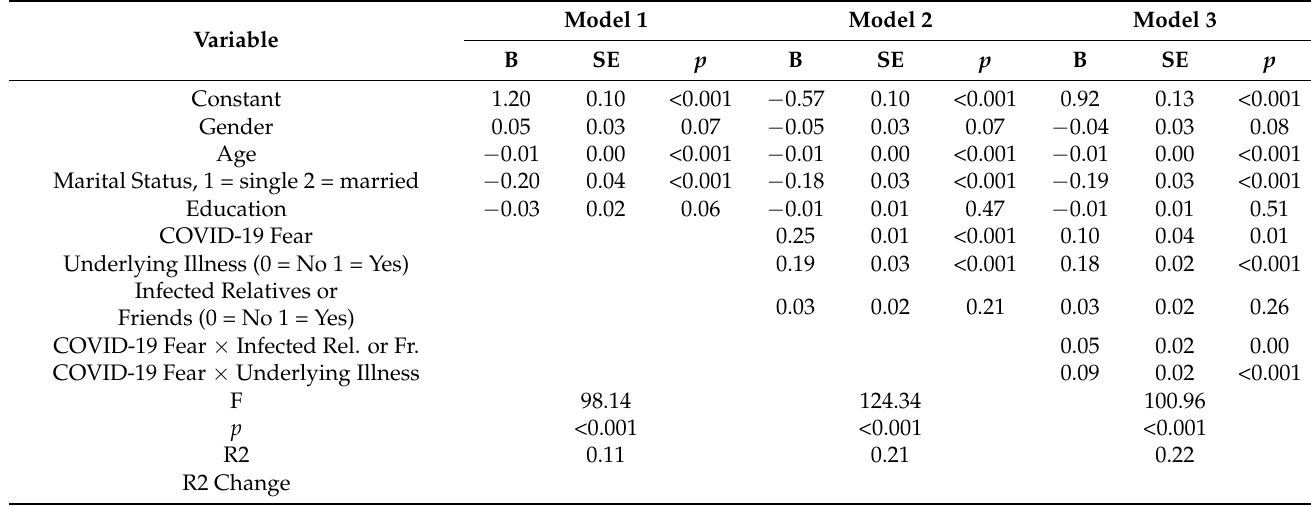
Table 3. Main and interaction effects on